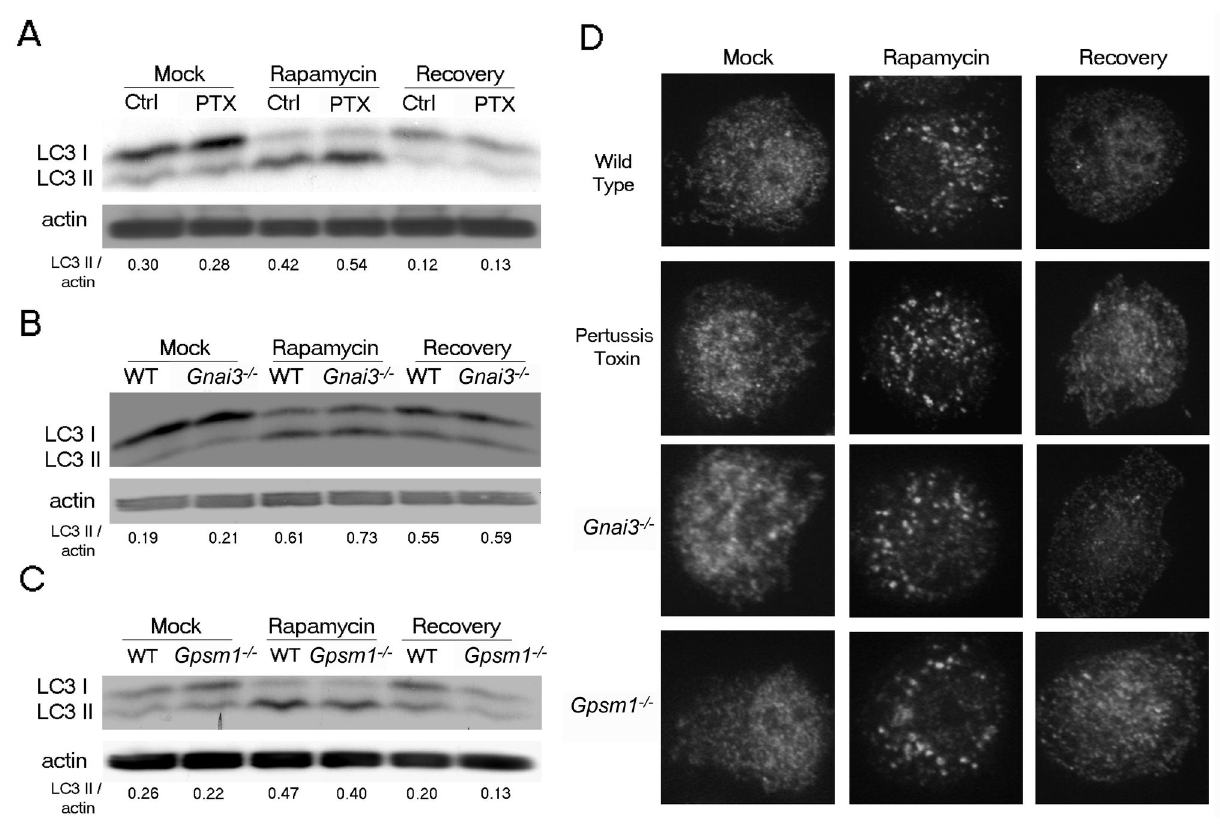
Figure 5. PTX treatment, the lack of Gα or the lack of AGS3 does not affect the anti-autophagic activity in primary mouse i3, macrophages. ( A ) Immunoblot analysis of cell lysates from BMDM prepared from wild type mice; or wild type mice pre-exposed to PTX ( B ) Gnai3 -/- mice; ( C ) Gpsm1 -/- mice, either not further manipulated, treated with rapamycin (50 μg/ml for 2h), treated